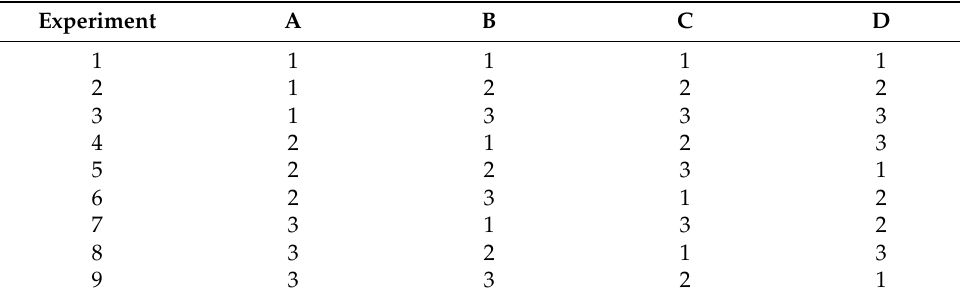
Table 2. Taguchi orthogonal L 9 (3 4 ) design matrix.